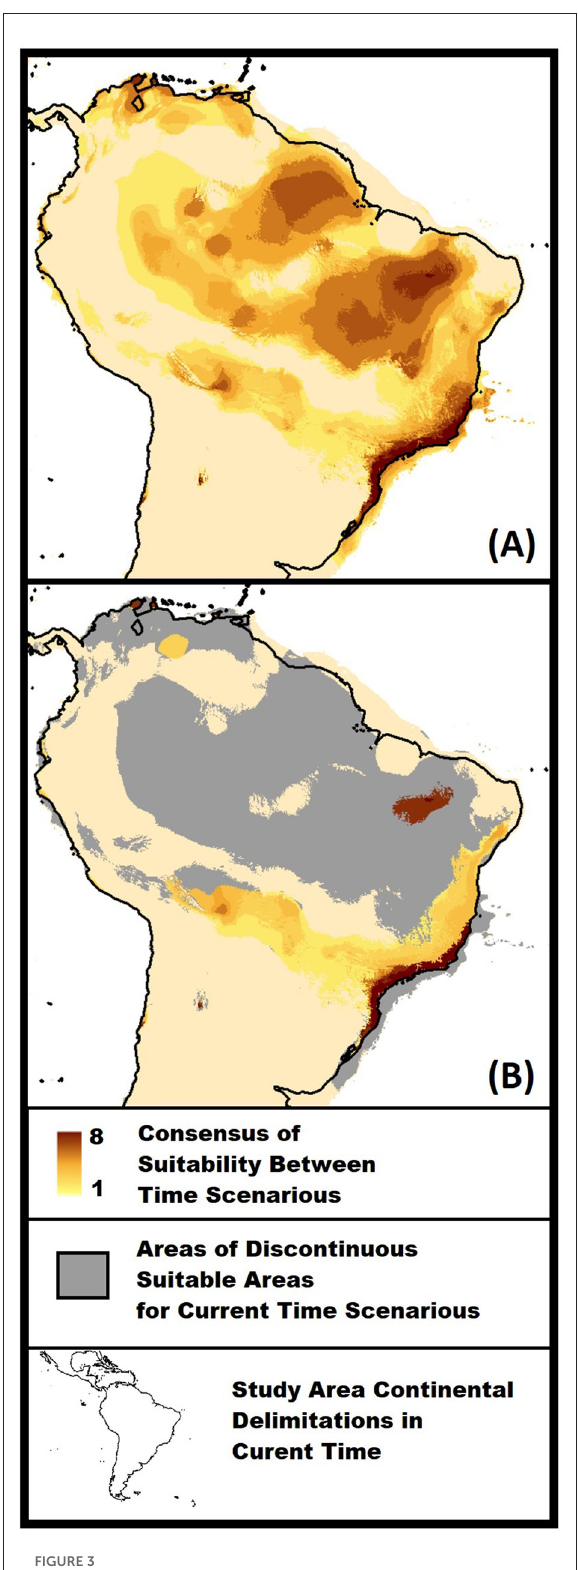
FIGURE3 Models of binary consensus through time. Consensus values range from 1 to 8 and are represented by light yellow to